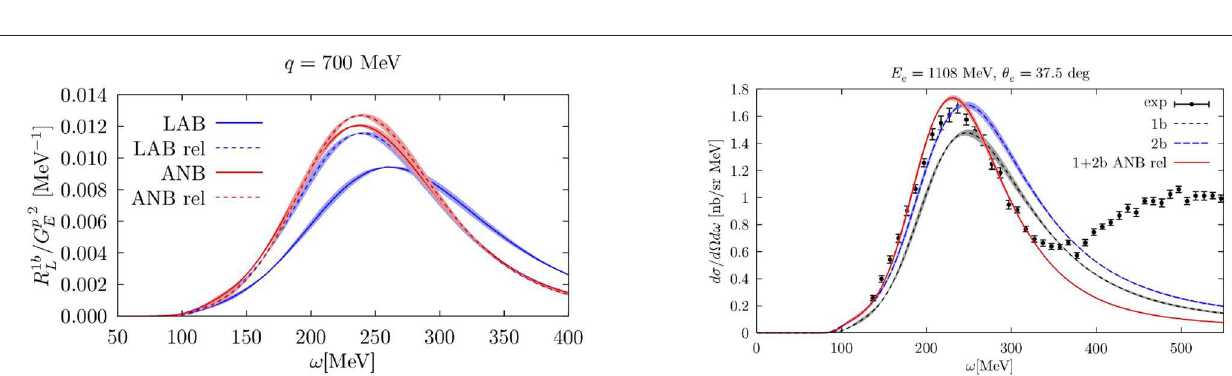
FIGURE 2 | Longitudinal electromagnetic response functions of 4 He at | q | = 300 MeV (left) and | q | = 500 MeV (right) obtained inverting the Laplace and Lorentz integral transforms compared to the experimental data of Carlson et al. [88].